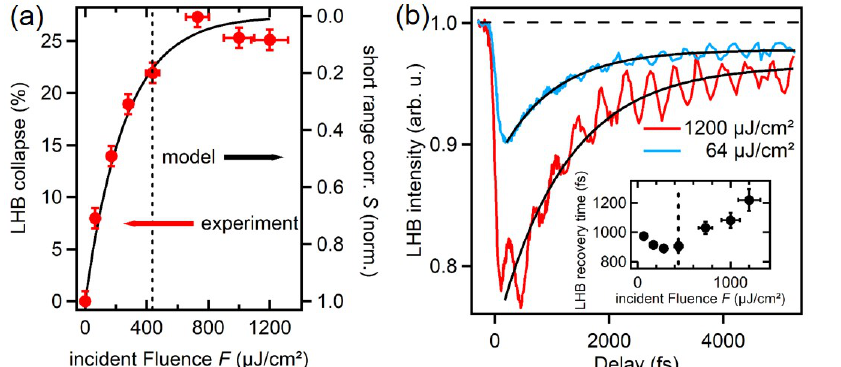
Figure 3. ( a ) Maximum collapse of the LHB peak intensity as a function of incident pump fluence, as extracted from the transient LHB intensity ( b ). The solid black line in ( a ) shows the result of the model calculation (see text) and the corresponding quench of short-range correlation S . The vertical dashed line indicates the fluence at which deviations from a linear dependence are found and the LHB collapse starts to saturate; ( b ) Time dependence of the LHB signature for two selected excitation fluences ( F = 1200 µ J cm − 2 and F = 64 µ J cm − 2 ). Solid lines are exponential fits used to extract the LHB recovery times (inset in ( b )), neglecting the oscillatory part of the signal. The resulting error bars are shown in the inset. Please note that the saturation level at higher delays is below the value obtained before pumping (indicated by the dashed horizontal